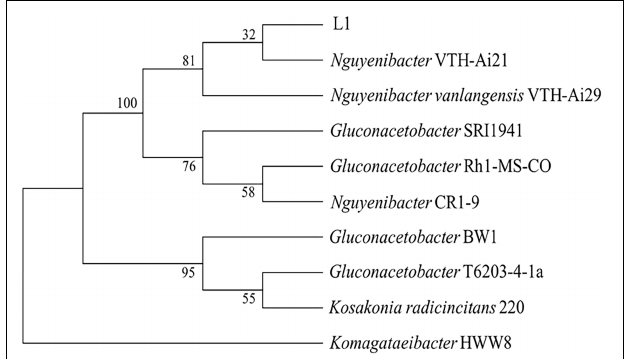
FIGURE 1 | Neighbor-joining phylogenetic tree based on 16S rRNA gene sequences of the screened strain and other bacterial strains. Numbers at nodes are bootstrap values (%).